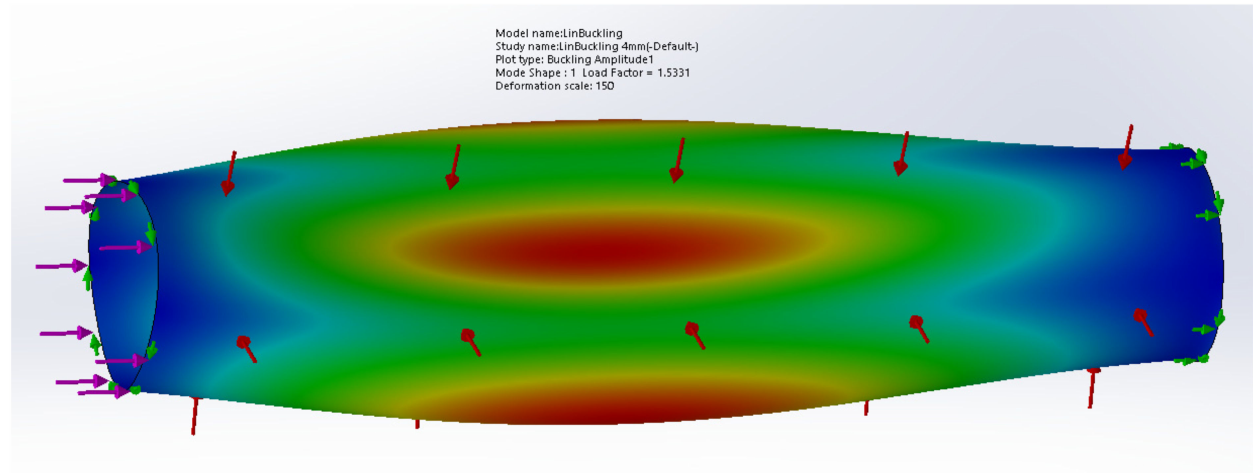
Figure 6. Simple cylinder–linear buckling FEA: loads, boundary conditions, mesh and mesh details. (Red arrows indicate loads, green arrows indicate applied fixtures).